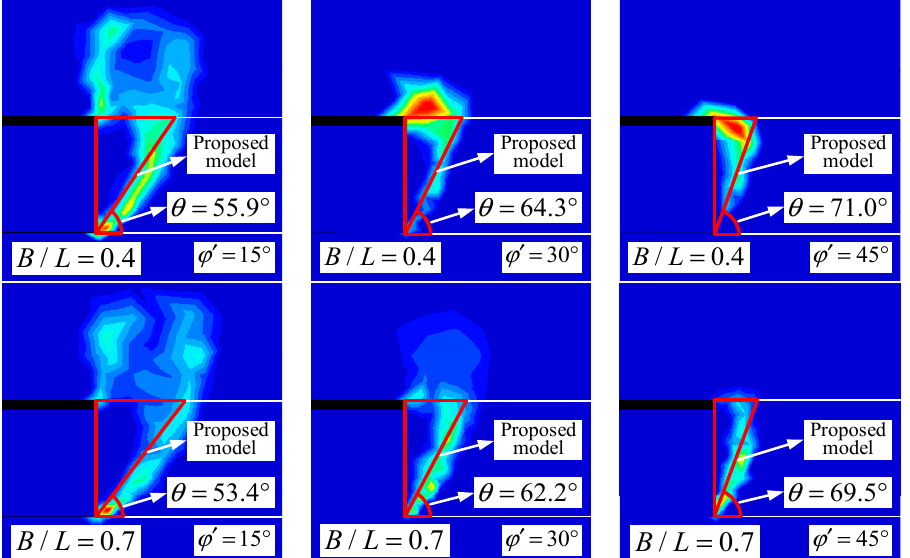
Figure 12. Comparison of failure geometries obtained with the proposed mechanism and with the numerical model for different strength parameters.